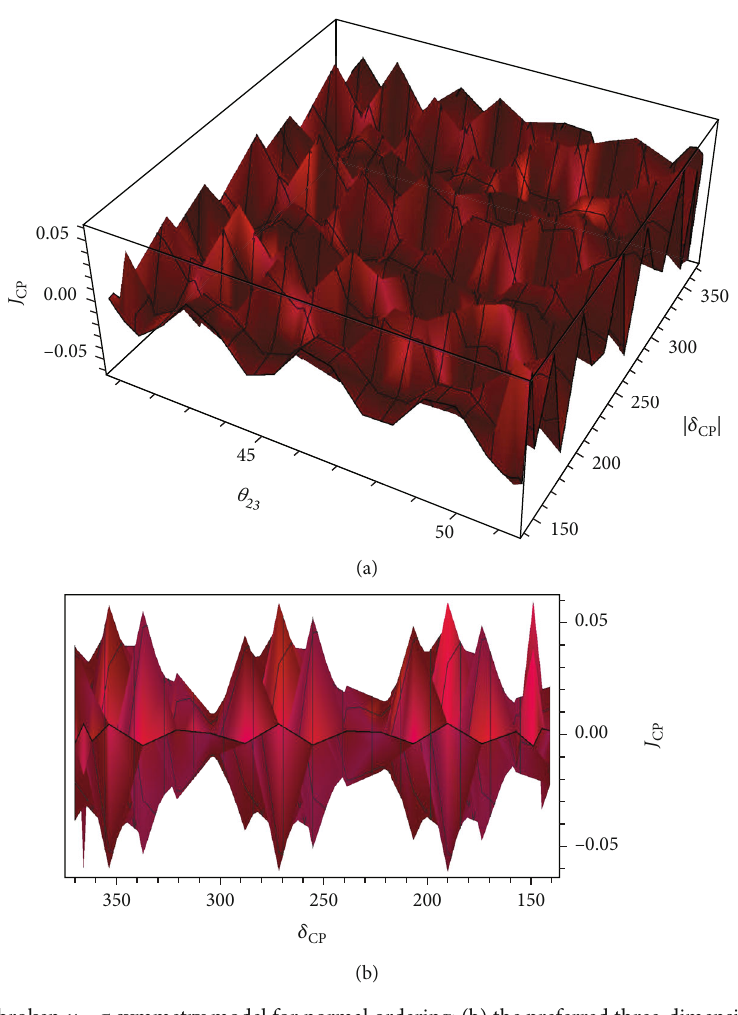
, θ , CP 23 , J ) plane for the CP CP